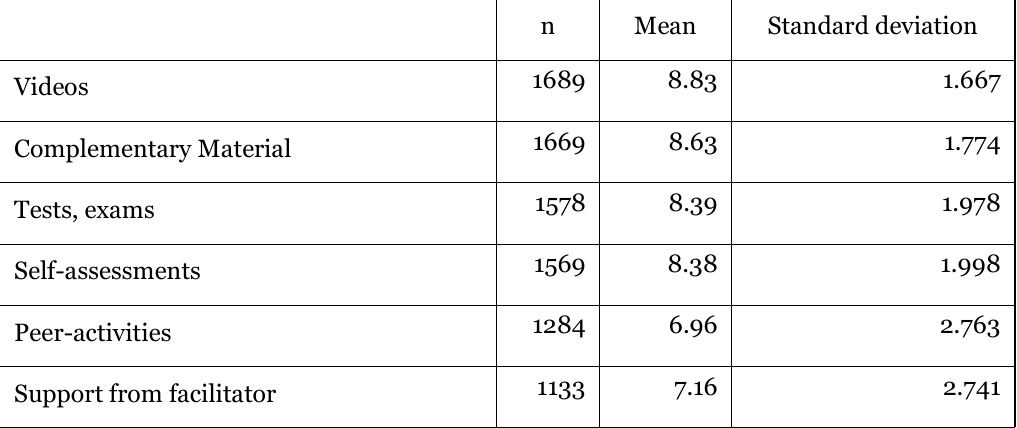
Degree of Need and Usefulness of MOOCs Tools for Learning and Progress (From 1 to 10)